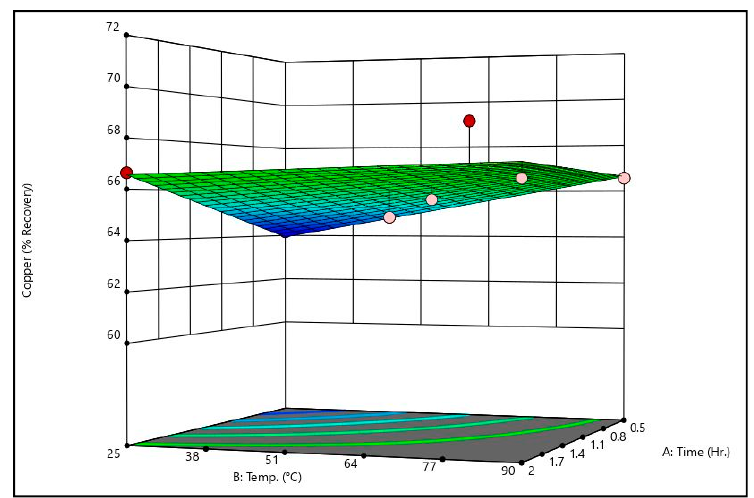
Figure 13. Water leach copper recovery response surface.